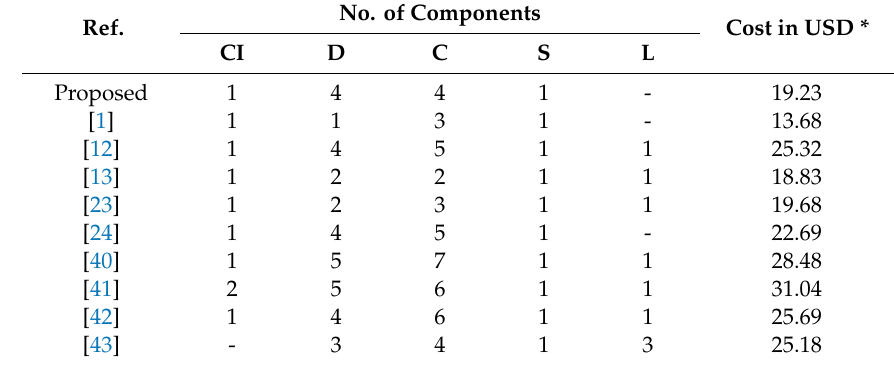
Table 7. Cost comparison among various converters for 100 W experimental prototype.